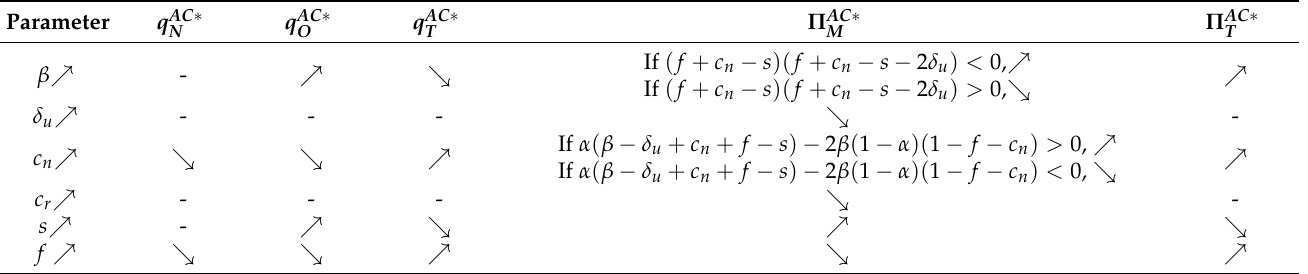
, q AC ∗ , q AC ∗ , Π AC ∗ , and Π AC ∗ with respect to β , δ u , c n , c r , s , and f . M T N T O